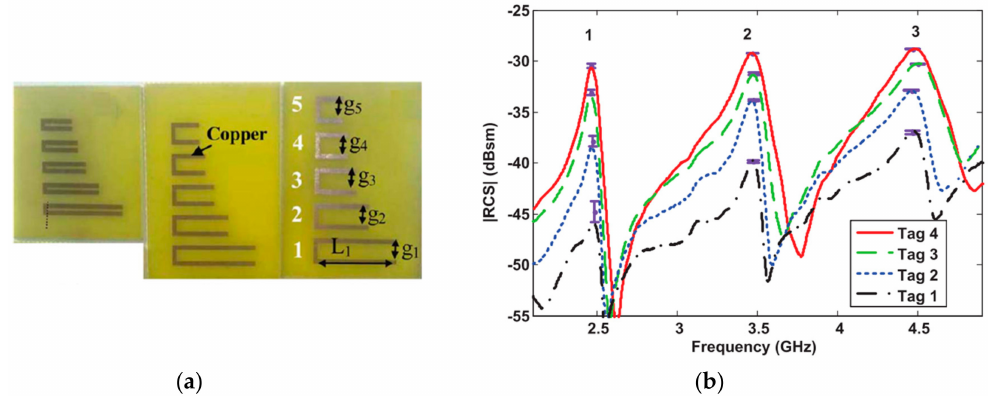
Figure 20. ( a ) Photograph of three chipless-RFID tags proposed by Vena et al. and ( b ) the measured frequency response. Figure extracted from